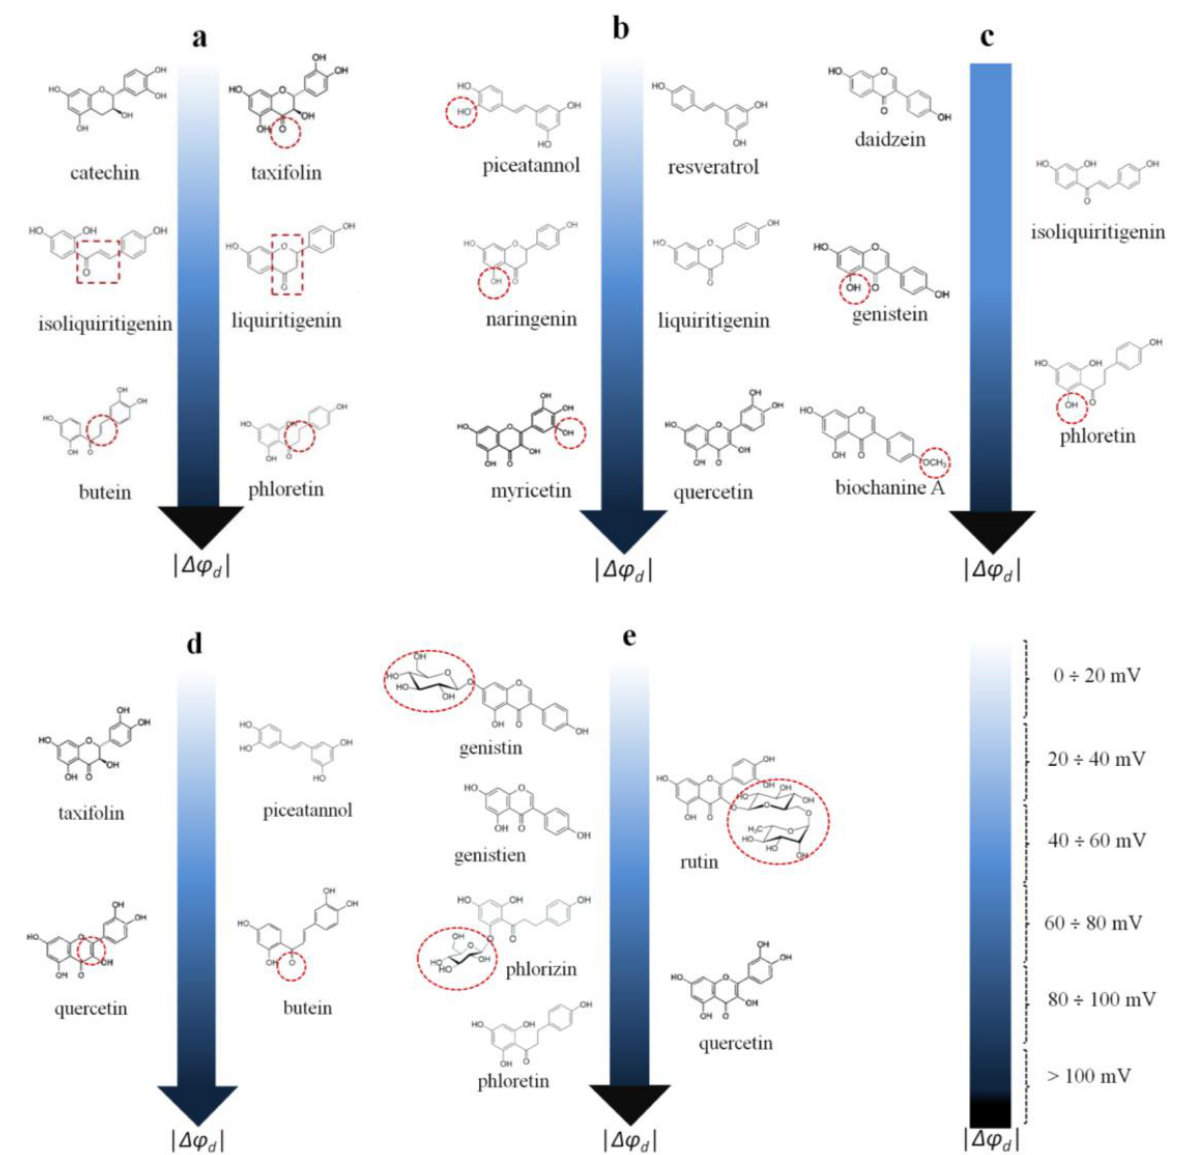
Figure 5. The relationships between the structure of polyphenols and their dipole-modifying ability. ( a ) The independence of dipole-modifying effect of polyphenols on the presence of the carbonyl group, heterocycle and double bond in the fragment linking the phenolic rings of molecules (from top to bottom); ( b ) The independence of dipole-modifying effect on inclusion of an additional OH group in the molecules of flavanones, flavonols, and stilbenoids (from top to bottom); ( c ) The dependence of dipole-modifying ability of isoflavones (left side) and chalcones/dihydrochalcones (right side) on the inclusion of additional OH- and methyl groups; ( d ) The dependence of dipole-modifying ability of flavonoid on the presence of the double bond in the heterocycle (left side) and the oxidation and length of the fragment linking the phenolic rings (right side); ( e ) The dependence of dipole-modifying ability of flavonoids on the glycosylation of isoflavones/dihydrochalcones (left side) and flavonols (right side).